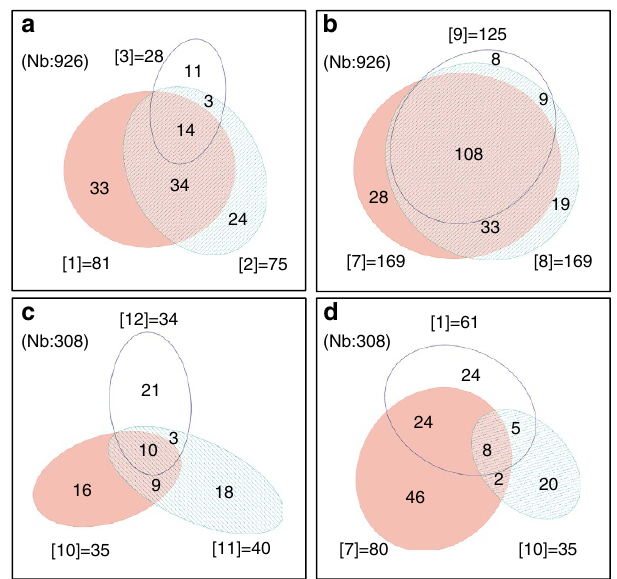
Figure 2 | Transferability of the intra-ring TPSA rule. ( a ) Venn diagram of OSNs responding to the single-ring ketones [1], [2] and [3]. If an OSN responds to [1] and [3] it always responds to [2]. ( b ) Venn diagram of